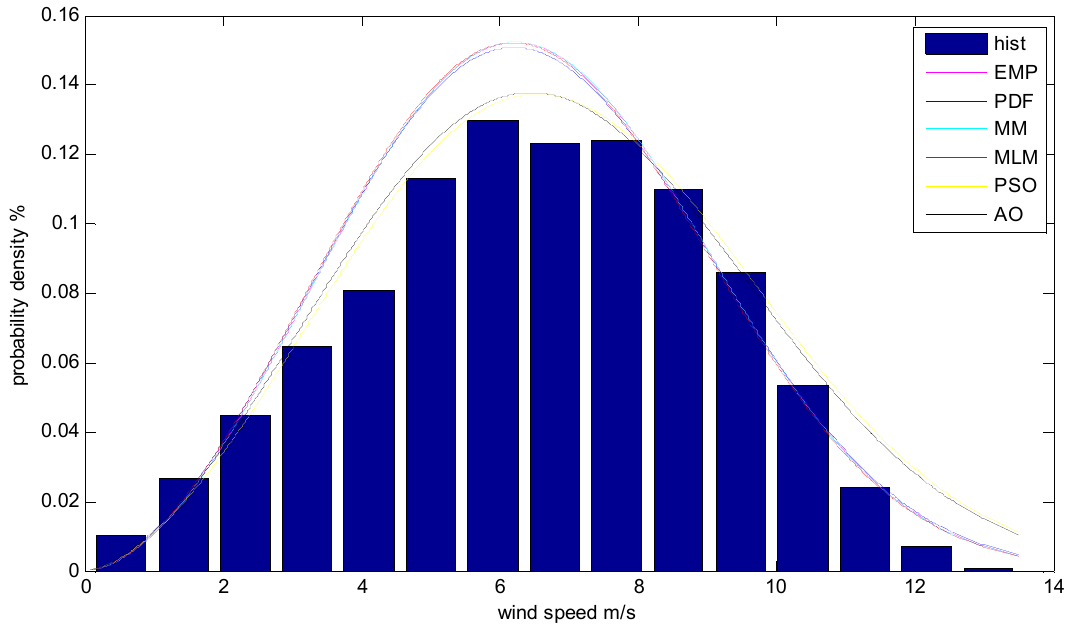
Figure 2. Weibull distributions: Zafarana site.